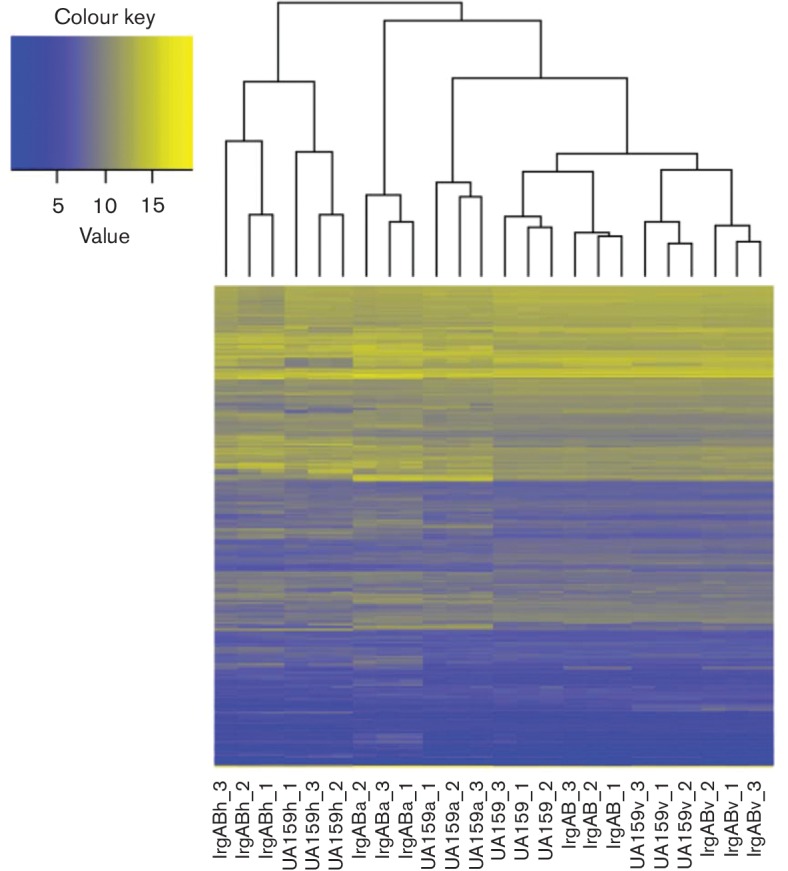
Cluster analysis of RNA-seq data. DE genes with >2.0-fold change and P<0.005 were clustered across all the samples based on the similarity calculated by Eucledian distance (indicated by tree at the top of the heat map). The heat map key represents the log2-transformed RPKM. The y-axis is the DE genes (unlabelled). Sample names are indicated at the bottom of the heat map (x-axis).